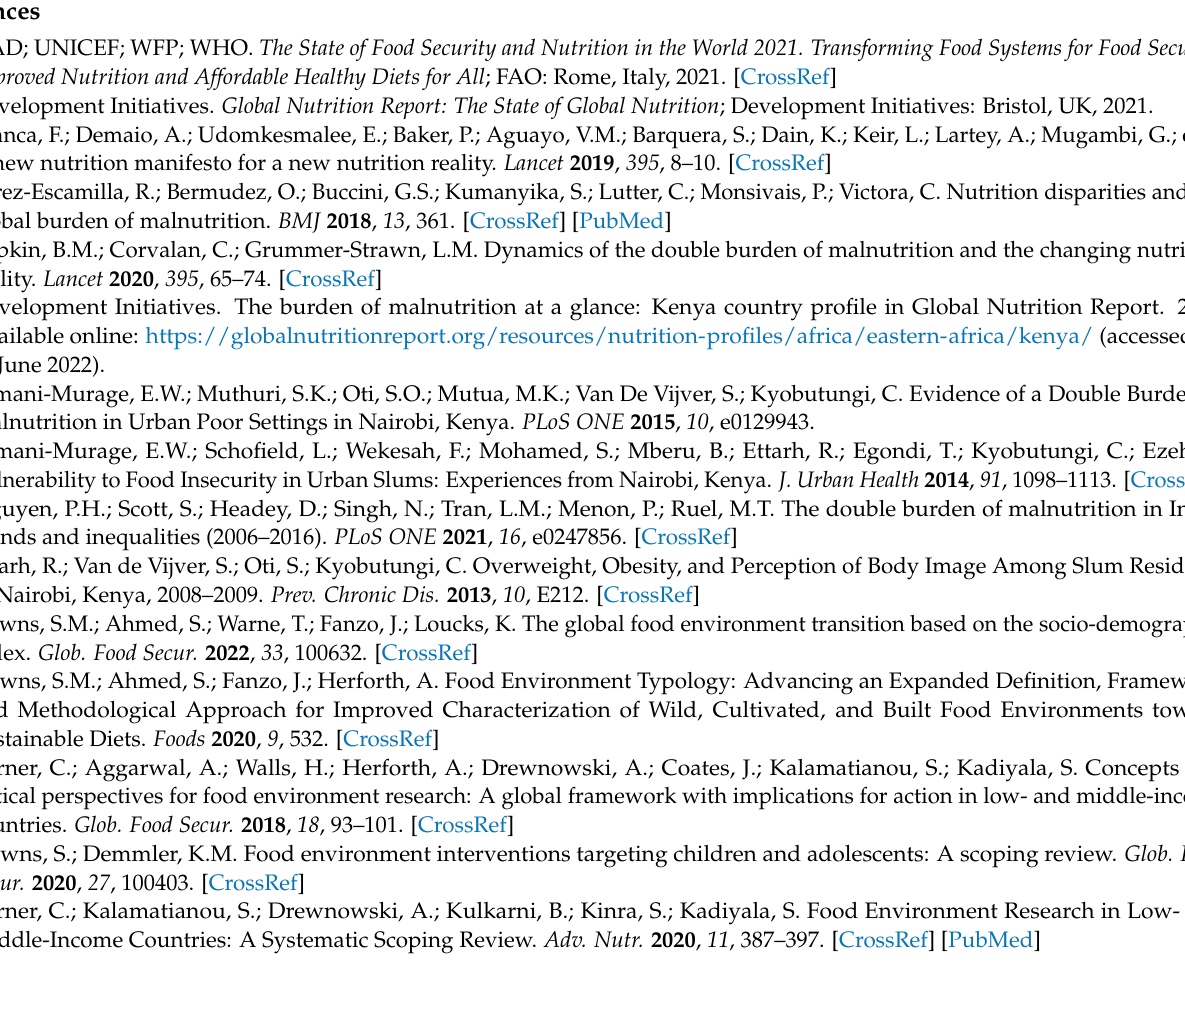
quality, Table S3: The average price of key food items in Kibera and Mukuru, Table S4: An overview of the sensory properties of fruits and vegetables in Kibera and